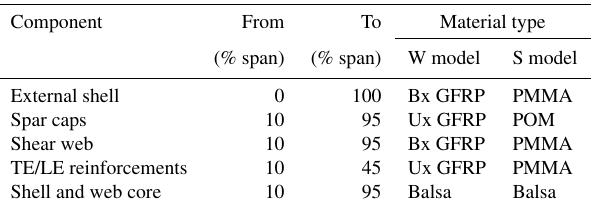
Table 9. Materials used for the structural components of the W- and S-model